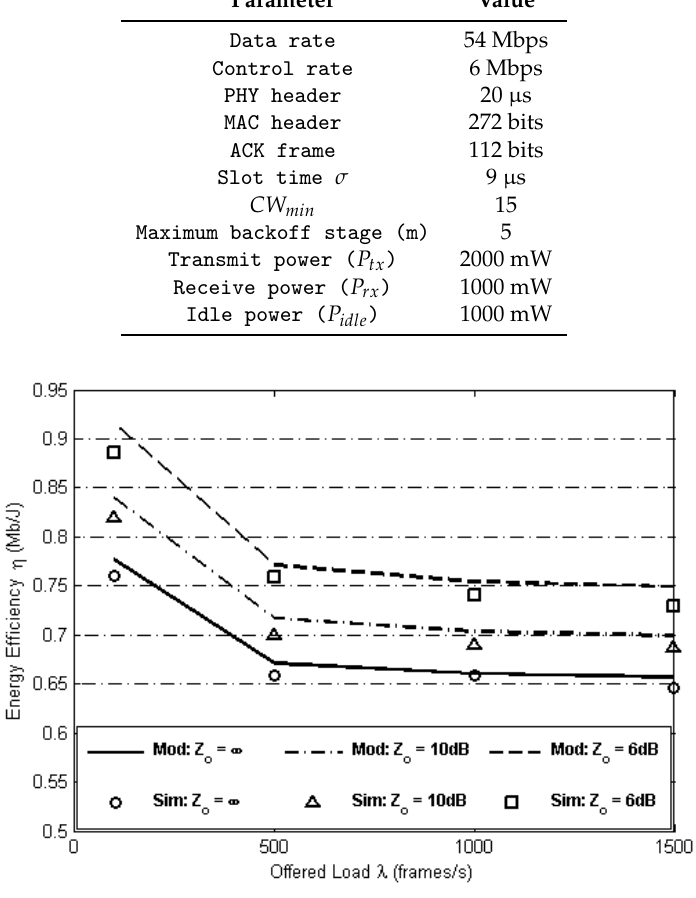
Figure 3. Energy efficiency in presence of capture against varying offered